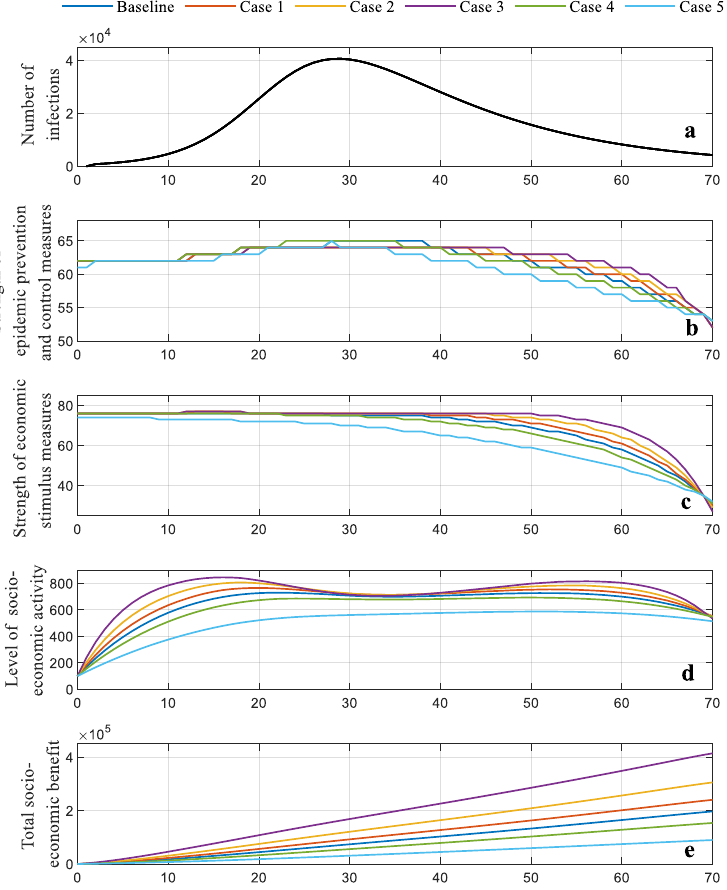
Figure 8. ( a ) Forecasted number of infections; ( b ) optimal trajectory of the strength of the pandemic prevention and control generated by DP; ( c ) optimal trajectory of the strength of the economic stimulation generated by DP; ( d ) optimal level of the socio-economic activity generated by DP; ( e ) total socio-economic benefit generated by DP.